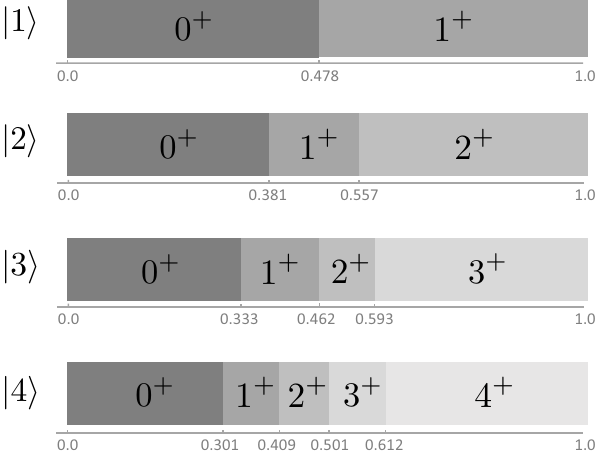
FIG. 3. Achievable fidelities with target Fock states | 1 (cid:3) , | 2 (cid:3) , | 3 (cid:3) , and | 4 (cid:3) , using states of finite stellar rank. In each fidelity region, the number indicates the minimal stellar rank of states achieving these fidelities, i.e., it corresponds to the minimal num- ber of photon additions and/or subtractions needed to build these states, together with Gaussian